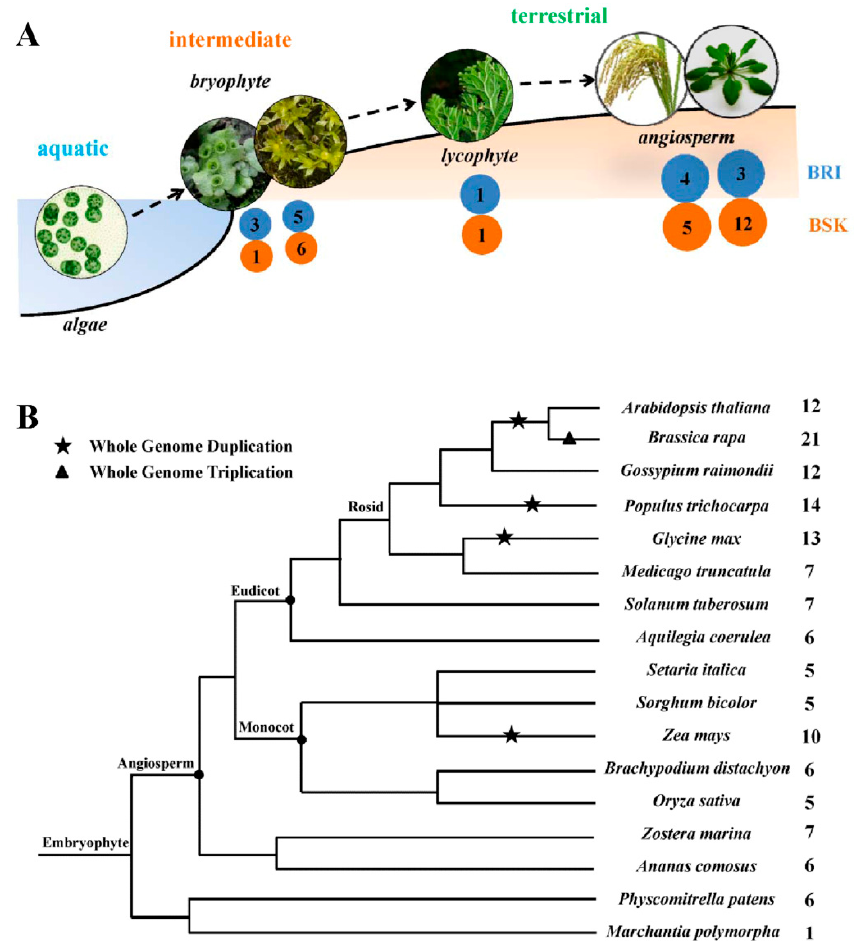
Figure 1. A comparative analysis of BSK genes in plants. ( A ) Evolution of core components of brassinosteroid (BR) signaling from aquatic plants to land plants indicated by dotted arrows. As representatives, component numbers of bryophyte, lycophyte and angiosperm were obtained from Marchantia polymorpha , Physcomitrella patens , Selaginella moellendorffii , Arabidopsis thaliana , and Oryza sativa , respectively. The numbers of BRI1-like and BSK proteins were indicated within blue and yellow circles, respectively. ( B ) The evolutionary relationships and the numerical details of the BSK family of each species.